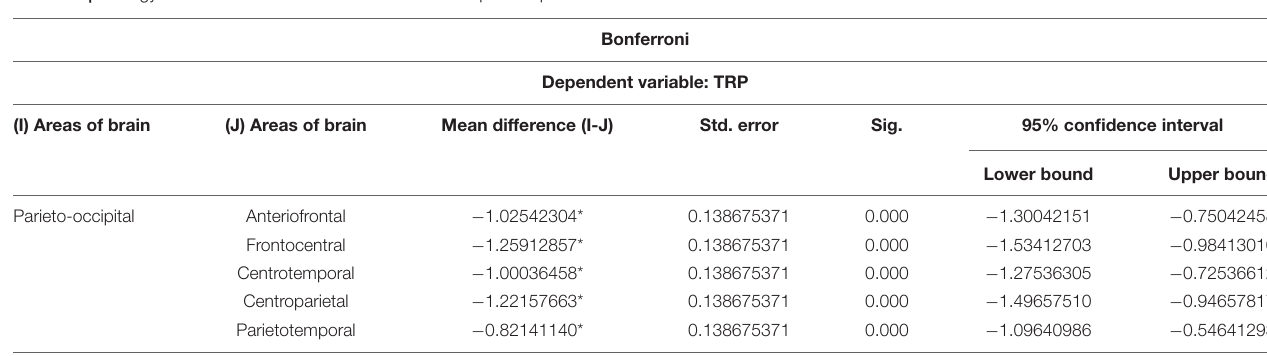
TABLE 7 | Analogy and inference: theta-band Bonferroni multiple comparison.